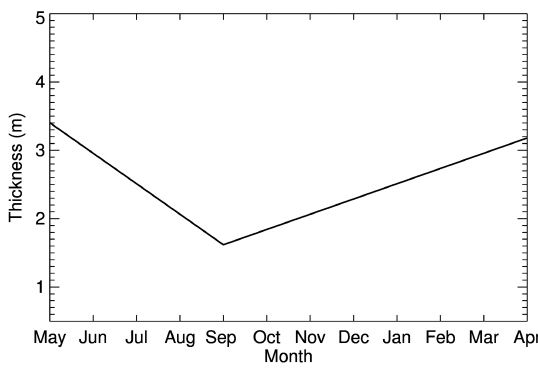
Figure 3. Modeled annual cycle of sea ice